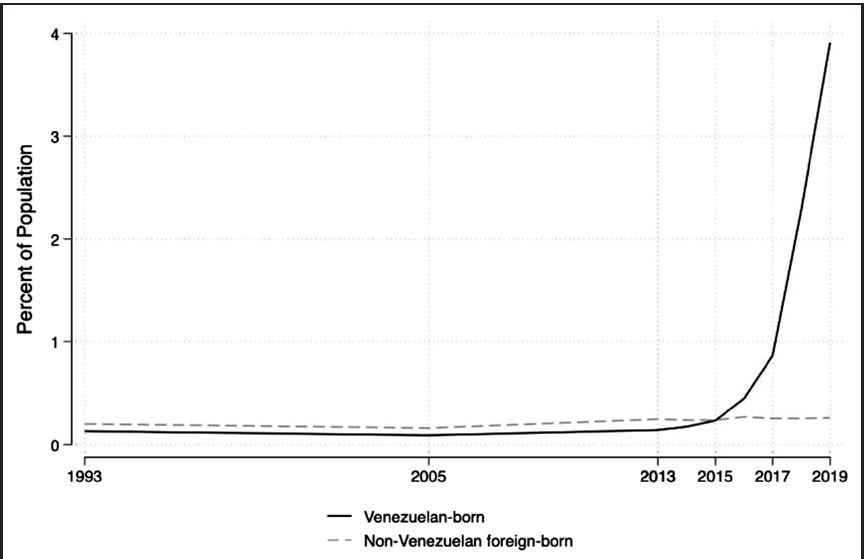
Figure 1 Foreign-born population in